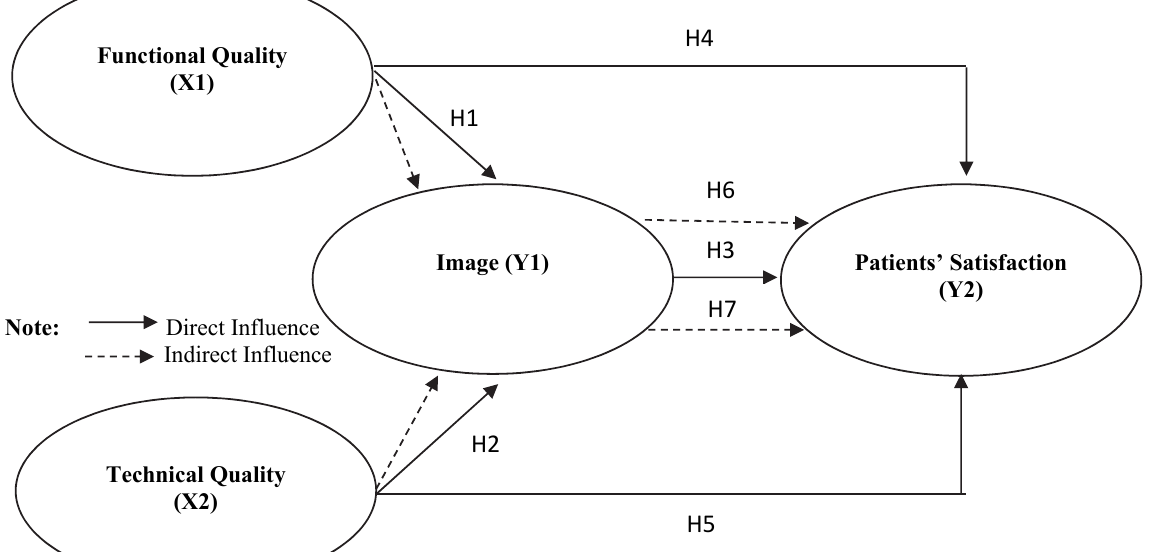
Fig. 1. Conceptual